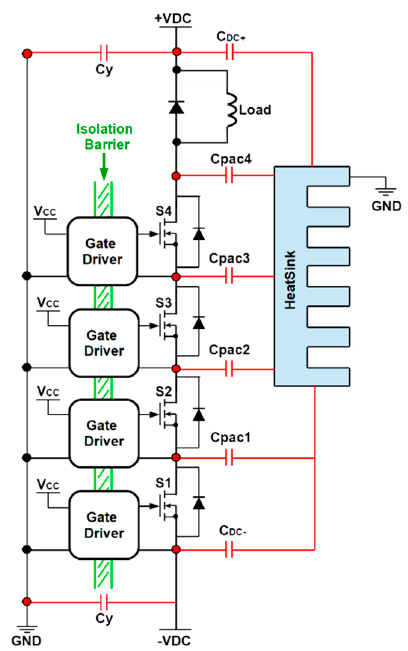
Figure 2. Equivalent electrical scheme of four SiC-MOSFETs connected in series in a 2D planar package.